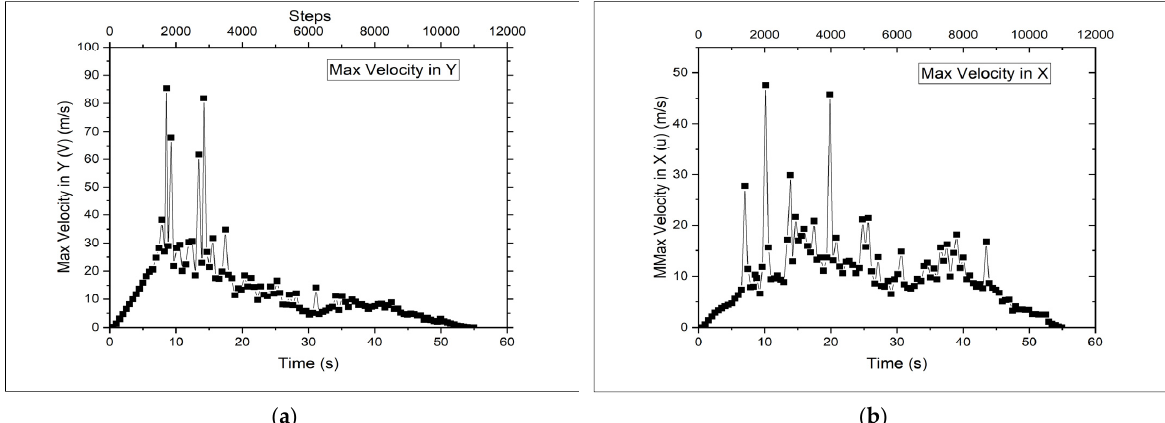
Figure 15. Average velocity of landslide mass in the ( a ) vertical direction (y-direction) and ( b ) horizontal direction (x-direction).